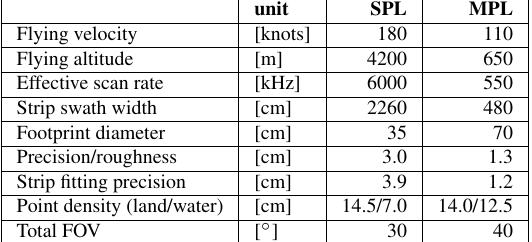
Table 2. Flight mission parameters and selected quality control measures for Single Photon LiDAR (SPL, Navarra) and Multi-Photon LiDAR (MPL, Neubacher